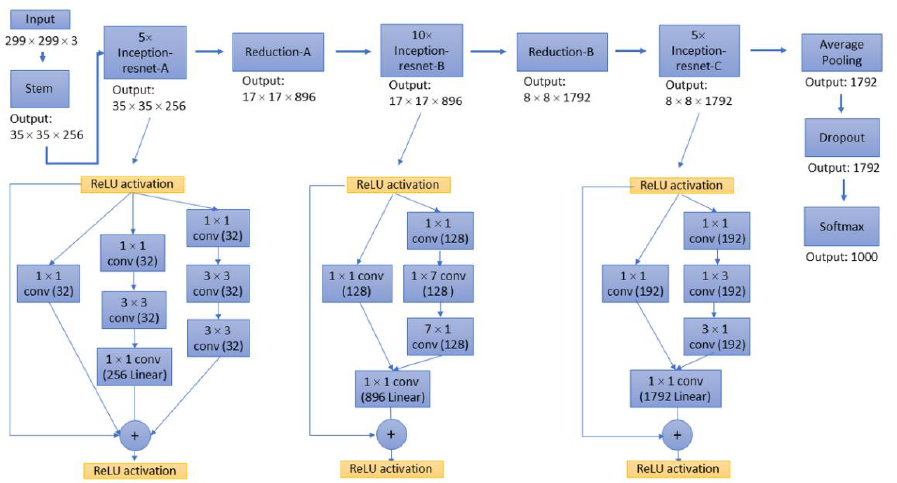
Figure 4. Network architecture of Inception-ResNet-v2. Illustrations of the reduction block structure were omitted.